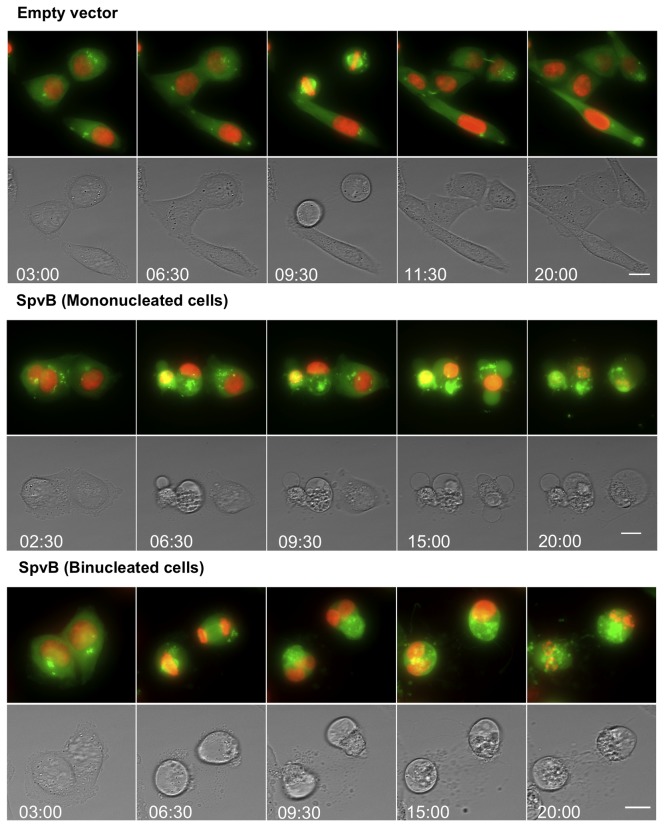
Confocal time-lapse imaging of infected cell with Salmonella MPO325 overproducing SpvB.HeLa cells expressing H2B-mCherry (red) and mEGFP–α-tubulin (green) were infected with Salmonella MPO325 bearing the empty vector or the plasmid producing SpvB and induced as in previous figure. Each cell behavior was monitored along the infection. Time is in hours. Maximum intensity projection of 16 z dimension slices. Scale bar: 15 μm.